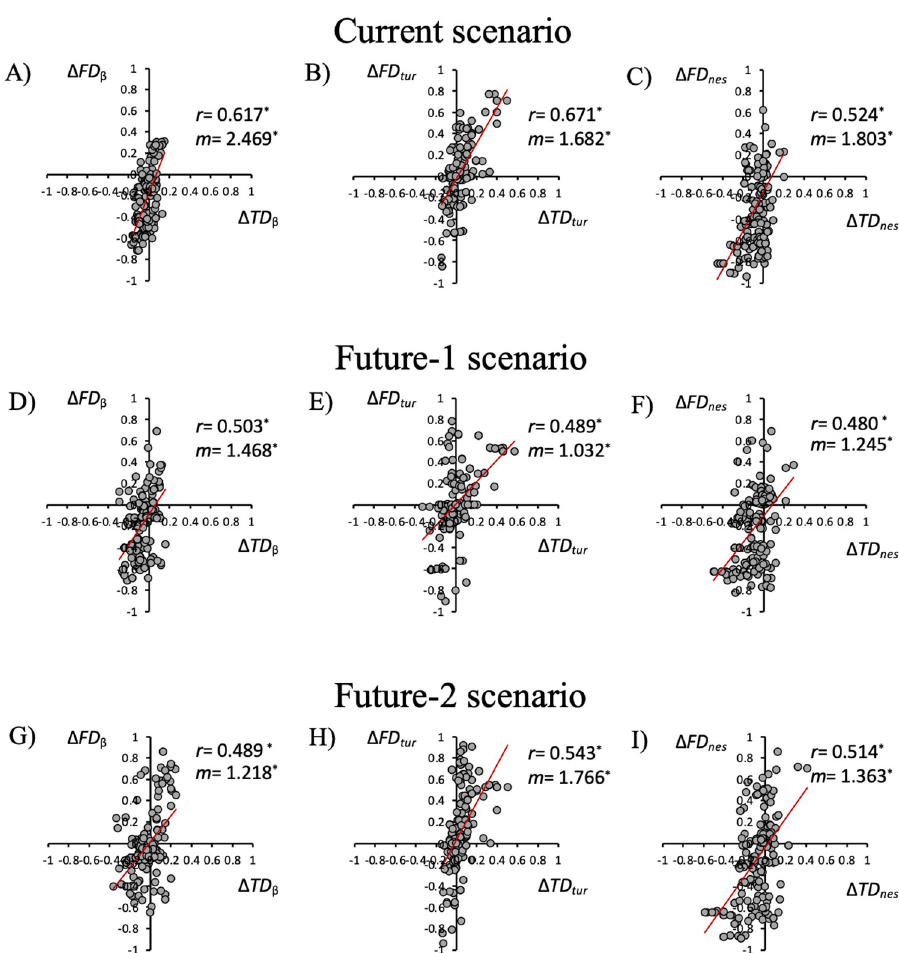
Fig 2. Regression/correlation between taxonomic ( Δ TD β , Δ TD Δ FD nes ) β -diversity, turnover, and nestedness for the current scenario and two hypothetical future scenarios (future-1 and future-2). 190 pairwise comparisons were used for each β -diversity index. The asterisk ( � ) indicates statistically significant correlation values ( r ) and/or regression slopes ( m ) that are statistically different from 1 (P < 0.05).